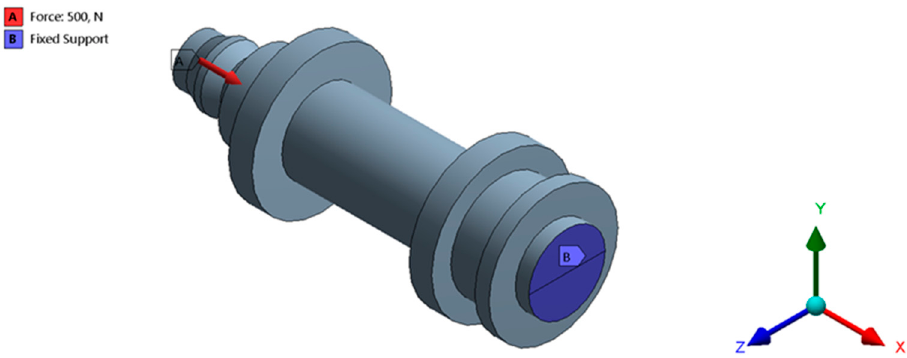
Figure 19. Boundary requirements and loads used for the numerical simulations.